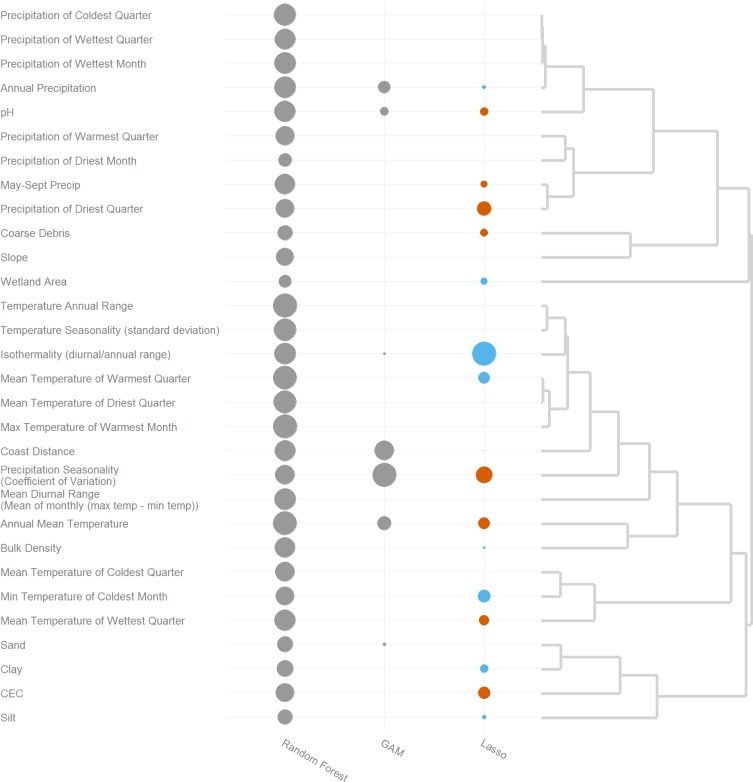
Relative importance of environmental variables for modeling methods.Heuristic comparison of variable importance by SDM model, with size scaled relative to the highest score for each model (score / max score). Dendrogram derived from correlation distance (1 –abs(correlation)) among environmental variables at sampling locations. For tree-based methods (Random Forest and CART), circle size proportional to average increase in node purity. For linear models, circles proportional to scaled coefficients, with red and blue indicating negative and positive coefficients respectively. For GAM, size proportional to X2 associated with a reduced model with the corresponding term deleted.